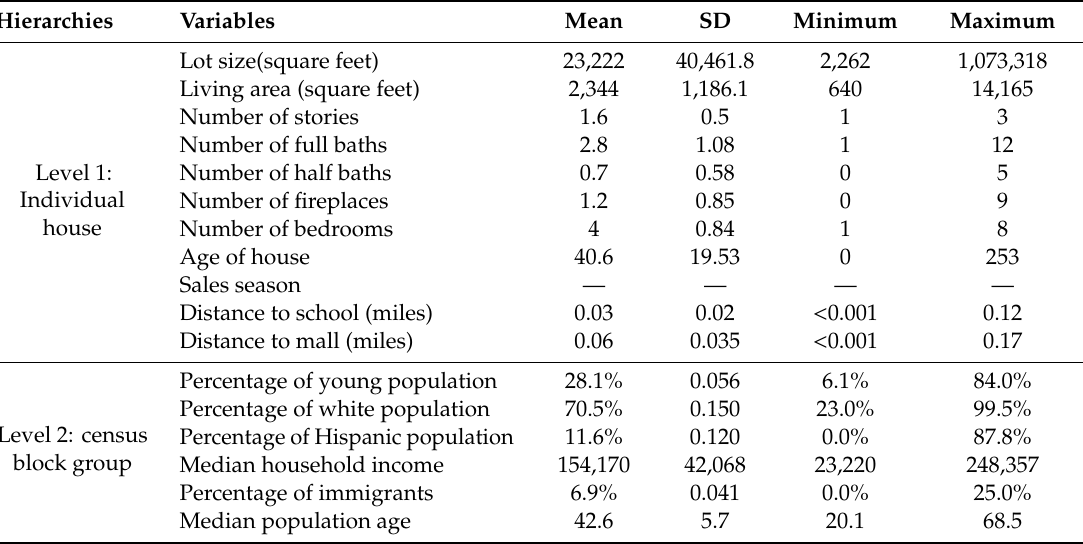
Table 1. Descriptive statistics of variables in the data analysis.